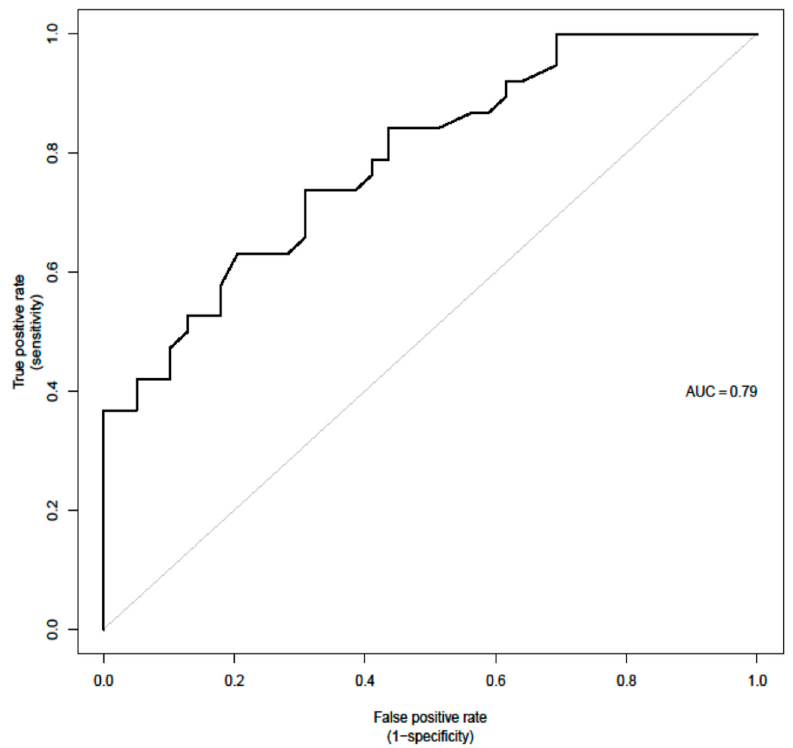
Figure 3. AUC for the final Radiotherapy model provided below.